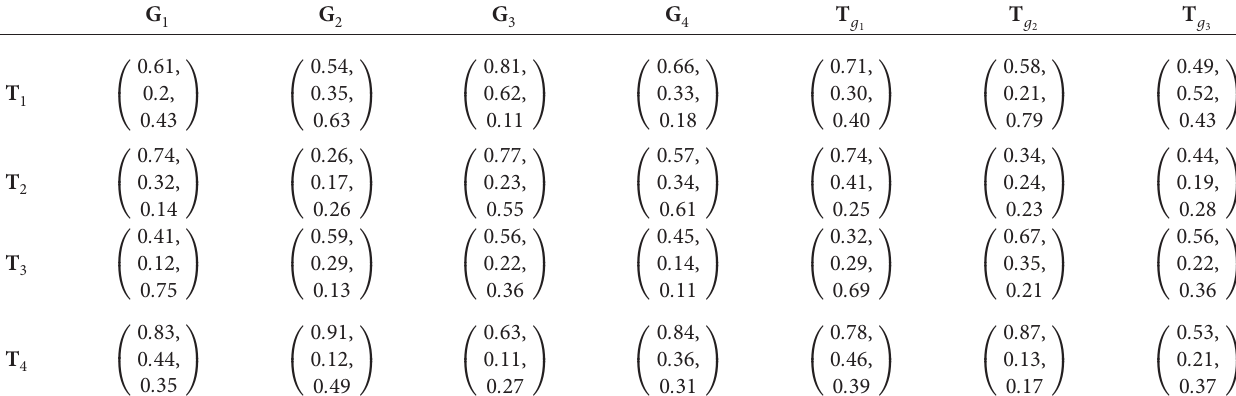
Table 4: Combination of Tables 1 and 2.